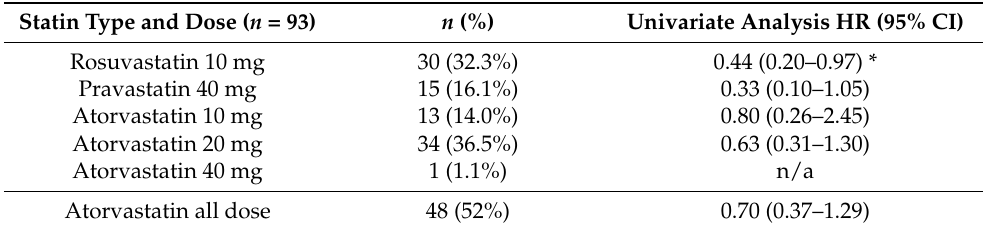
The prescription patterns and the associated with long-term outcome in the Cox regression